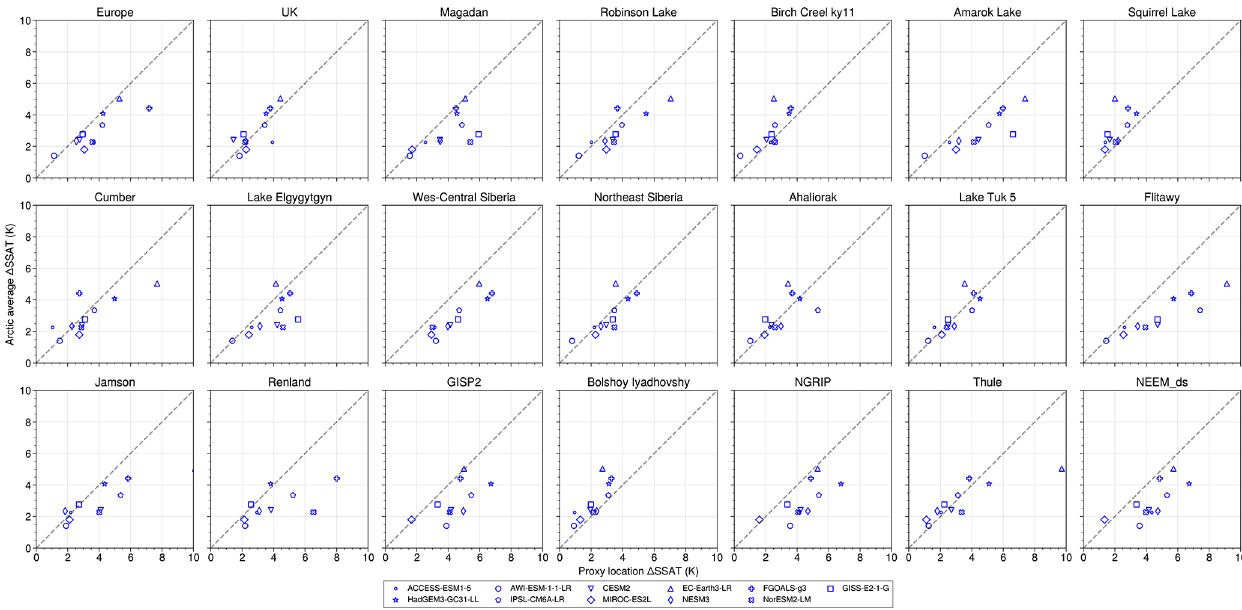
Figure A5. Scatterplot for climatological (cid:49) SSAT at each proxy location versus climatological (cid:49) SSAT averaged north of 60 ◦ N in each